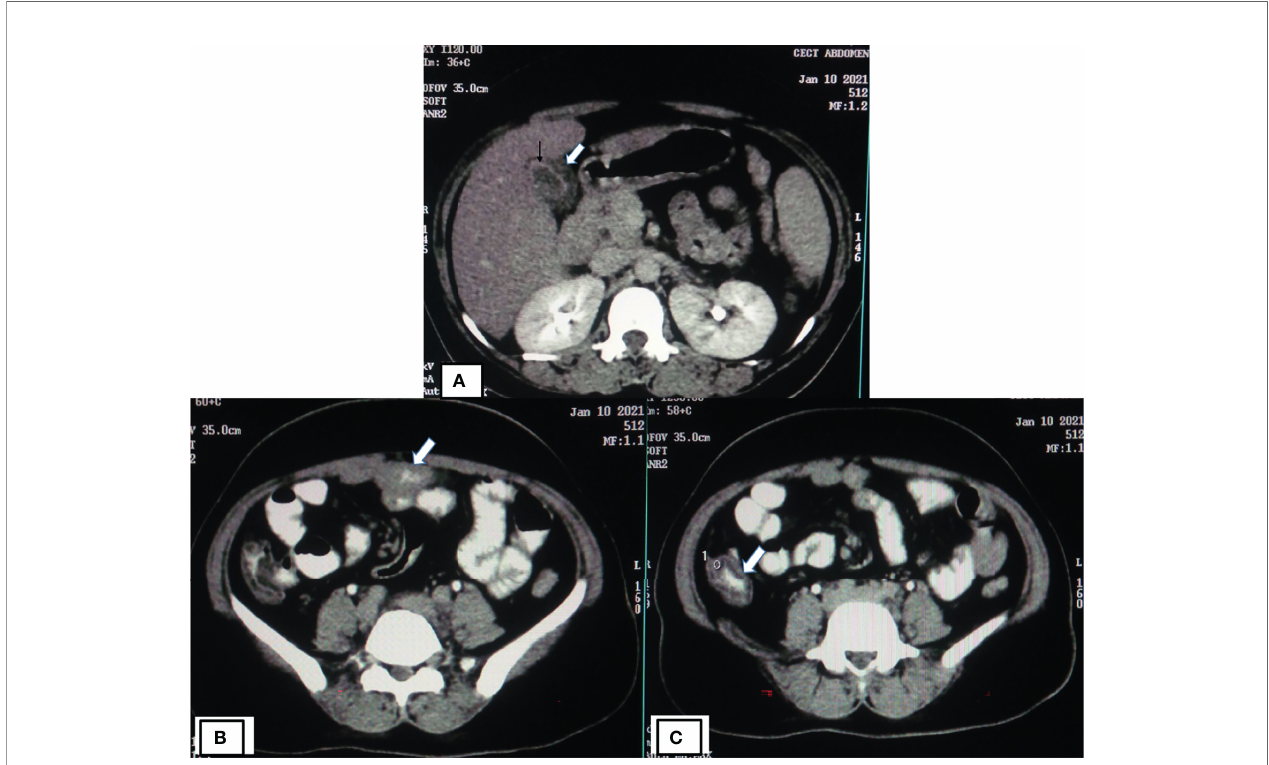
FIGURE 5 | CECT of COVID-19 patients showing gall bladder, small and large bowel wall thickening. (A) CECT abdomen of COVID-19 patients (same patient as shown in Figure 3 ) showing gall bladder wall thickening (thick white arrow) likely due to edema and mucosal enhancement (black arrow). CECT abdomen of same patient showing small bowel (thick white arrow) wall thickening (B) and large bowel (thick white arrow) wall thickening (C)